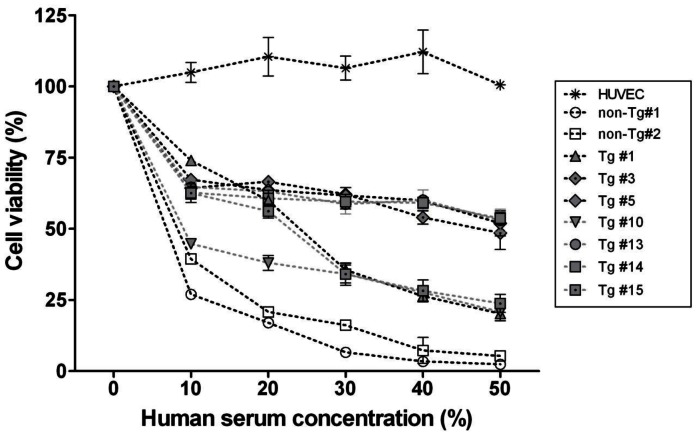
Human serum-mediated cytolysis of SUVECs.SUVECs from non-Tg (n = 2) and Tg (n = 7) were incubated for 6 h in MEM culture medium containing serial dilutions of normal human serum. Cytolysis rate was calculated based on the counts of live and dead cells. Mean ± SEM tested in three independent experiments are presented (P<0.001).